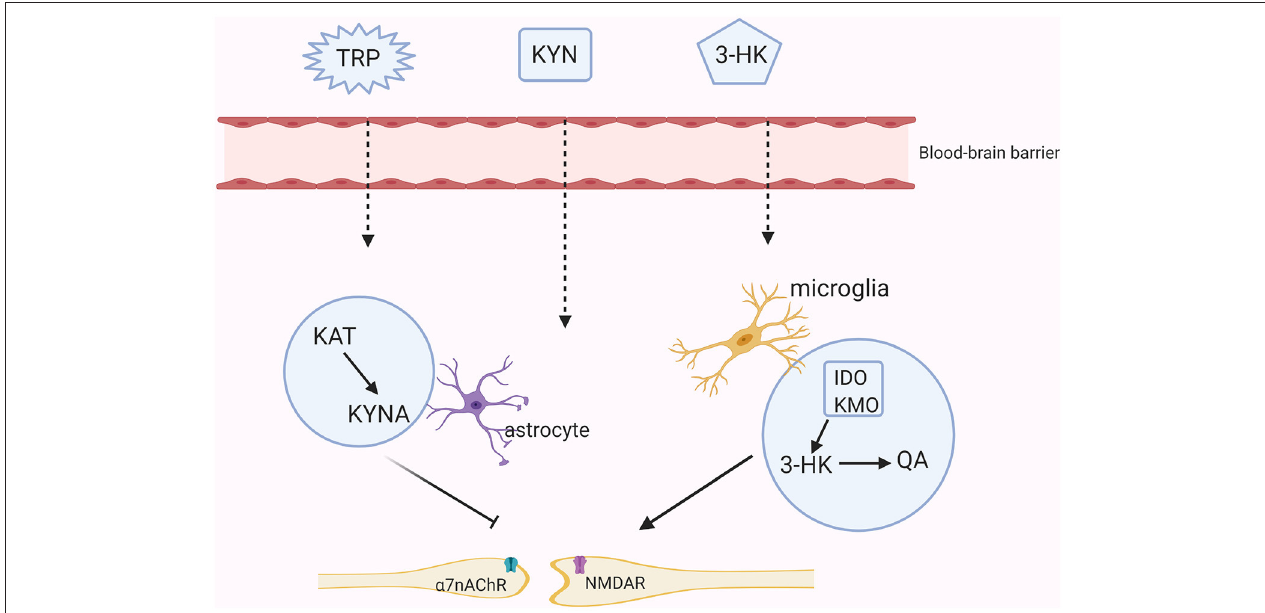
FIGURE 2 | The KYN pathway in the brain. Tryptophan (TRP), kynurenine (KYN), and 3-hydroxykynurenine (3-HK) all can cross the brain-blood barrier (BBB). In astrocytes, KYN is mainly metabolized into the neuroprotective metabolite- kynurenic acid (KYNA) through the kynurenine aminotransferase (KAT). KYNA inhibits the activities of the N-methyl-D aspartate (NMDA) receptor and the non-competitively α 7-nicotinic receptor ( α 7nAChR). While in microglia, KYN is further metabolized into an agonist of the NMDA receptor-quinolinic acid (QA) through indoleamine the 2,3-dioxygenase (IDO) and kynurenine monooxygenase